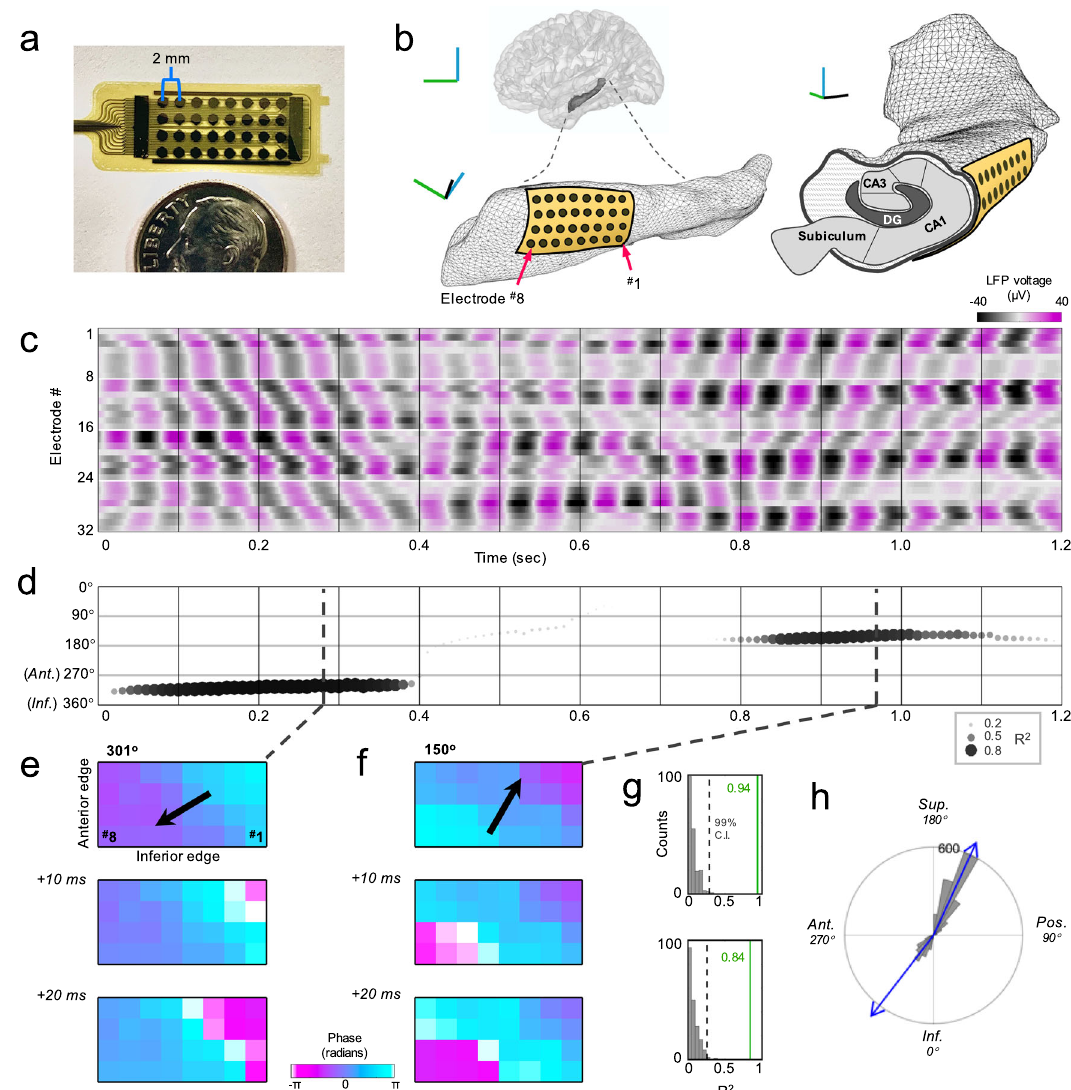
Fig. 1 Bidirectional traveling oscillations over the hippocampal surface. a Microgrid and connector (left) with dime for scale. b Lateral view of left hippocampus within 3D glass brain, and enlarged view (rotated) with approximate size and positioning of microgrid placement (blue line: superior, green: anterior, black: lateral). Coronal cross-section schematic of sub fi elds at right. c Filtered LFP around example peak frequency (13.8 ± 1.5 Hz, awake Participant 5) in color scheme (microvolts), white lines separate grid rows. Cycle lags evident across consecutive electrodes suggest spatiotemporal wave travel. d Direction of TW in ( c ) calculated every 10 ms (size and shading: regression R 2 ). In this segment, the oscillation initially travels antero-inferiorly, then directionality declines brie fl y (low R 2 ) followed by a robust reemergence in a postero-superior route. e Instantaneous phase shown in grid orientation for consecutive timepoints (top panel: dotted line in ( d )), phase gradient illustrating antero-inferior directionality. f Same as ( e ), for example, timepoints with postero-superior directionality. g Top and bottom panels show regression model R 2 values (green) for upper panels in ( e and f ), respectively, shuf fl ed distributions in gray (dotted line: 99% con fi dence interval). h Circular distribution of directions for this frequency for all baseline period timepoints (10° bins, blue arrows: modes; Inf: inferior, Pos: posterior, Sup: superior, Ant: